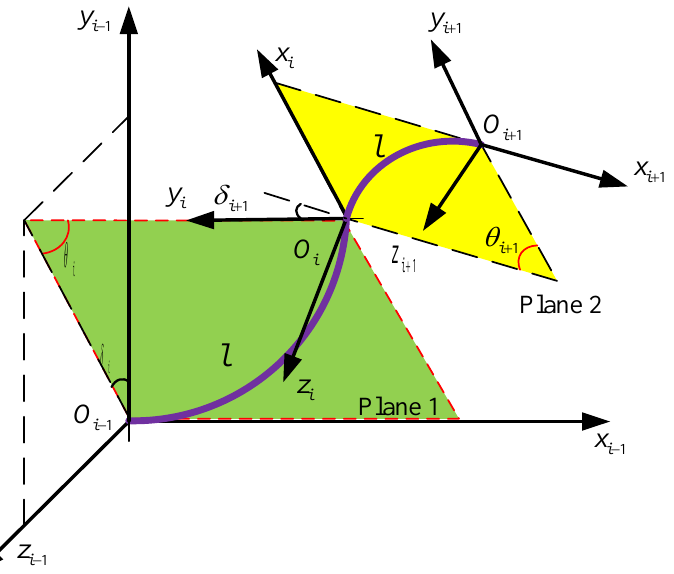
Figure 5. Schematic of the local coordinate system of continuum arm. The profile of the i th section can be described using θ i and δ i . θ i is the bending angle of the i th section and δ i is the rotating angle of the bending plane with respect to the x-axis of coordinate system R i − 1 . Therefore, six angles { θ 1 , θ 2 , θ 3 , δ 1 , δ 2 , δ 3 } can be used to describe the shape of each arm.